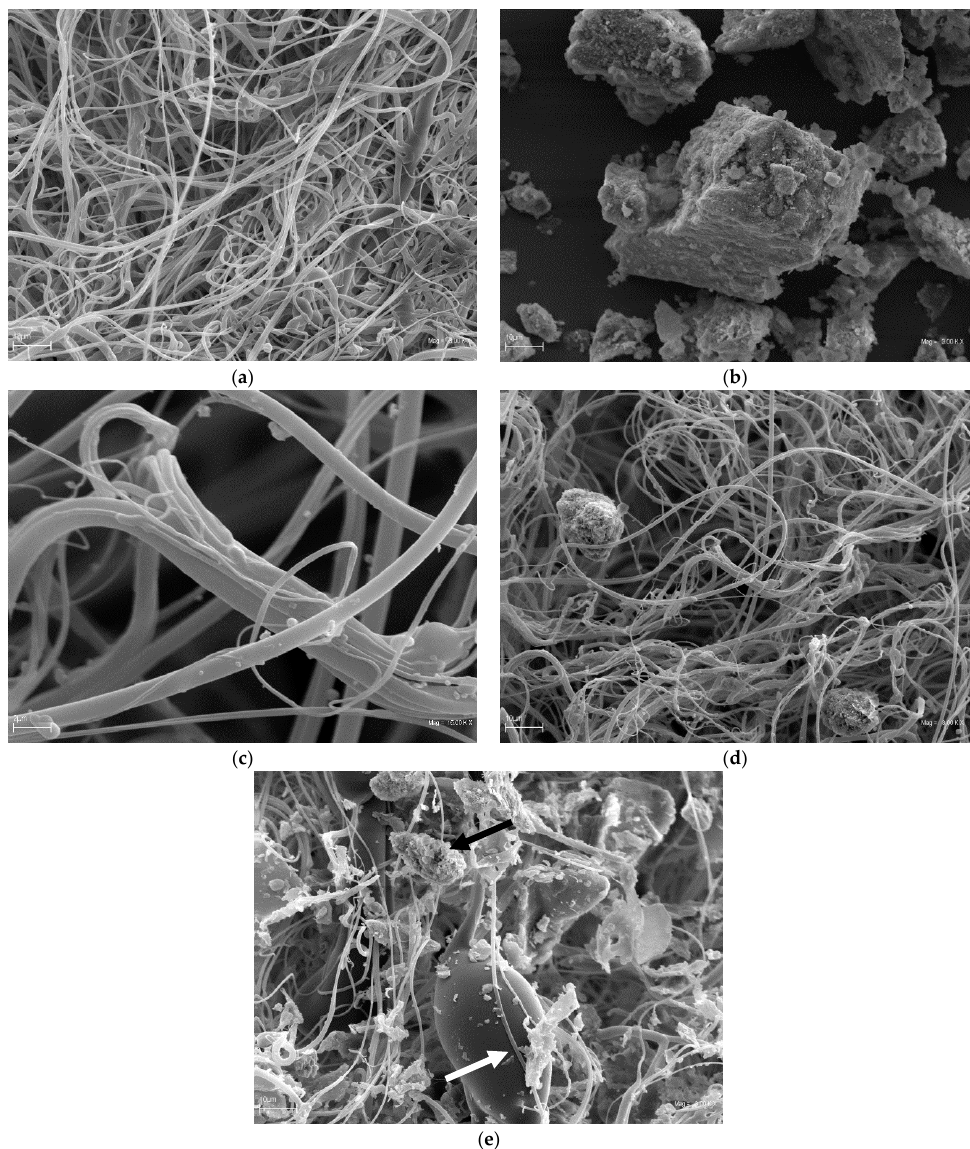
Figure 1. SEM images of: ( a ) control PP nonwoven (mag. 3000×); ( b ) SPBS particles and agglomerates (mag. 3000×); ( c ) PP/SPBS nonwovens with SPBS grains melted into PP fibres (mag. 15,000×); ( d ) PP/SPBS nonwovens with SPBS agglomerates entangled within the fibres (mag. 3000×); ( e ) PP/SPBS nonwovens with deposited biomass dust particles (SPBS agglomerate—black arrow, dust particle—white arrow, mag. 3000×).